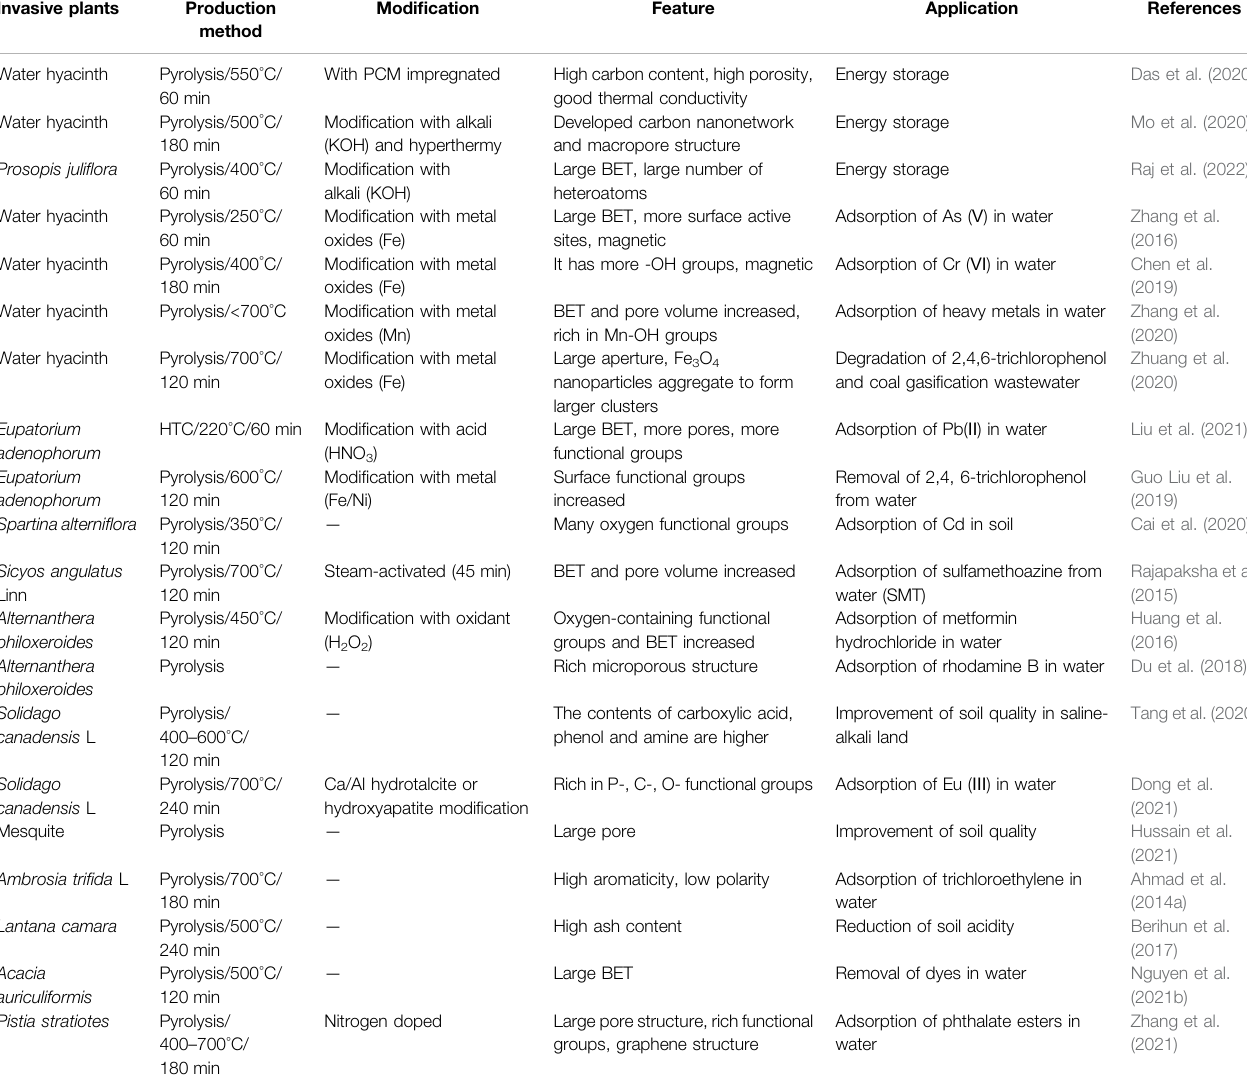
TABLE 1 | Preparation, modi fi cation, characteristic, and use of biochar from invasive plants. Invasive